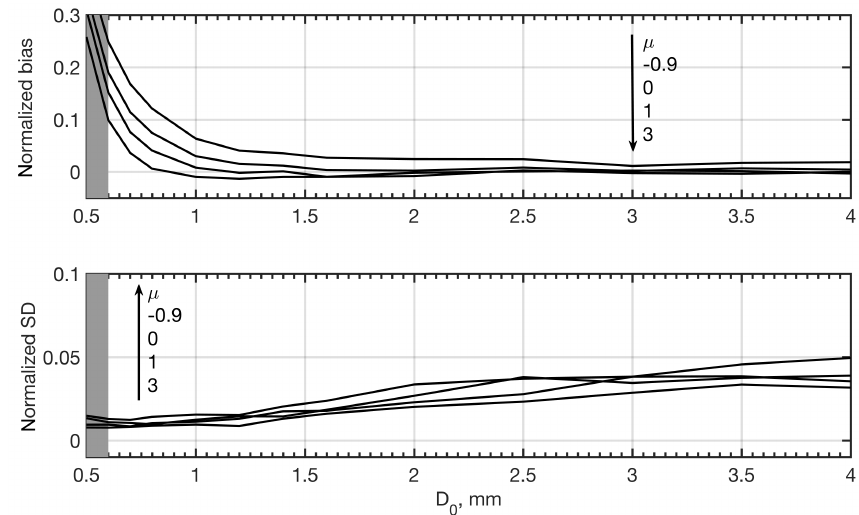
Figure 6. Computed normalized bias and standard deviation of estimated mean snow density as a function of µ and D 0 . The shaded area indicates data that are not included in the analysis because derived D 0 is smaller than 0.6mm. The increased values of bias at low D 0 values is due to left side truncation of the observed PSD, which is caused by the instrument sensitivity. At larger D 0 values the bias approaches value of